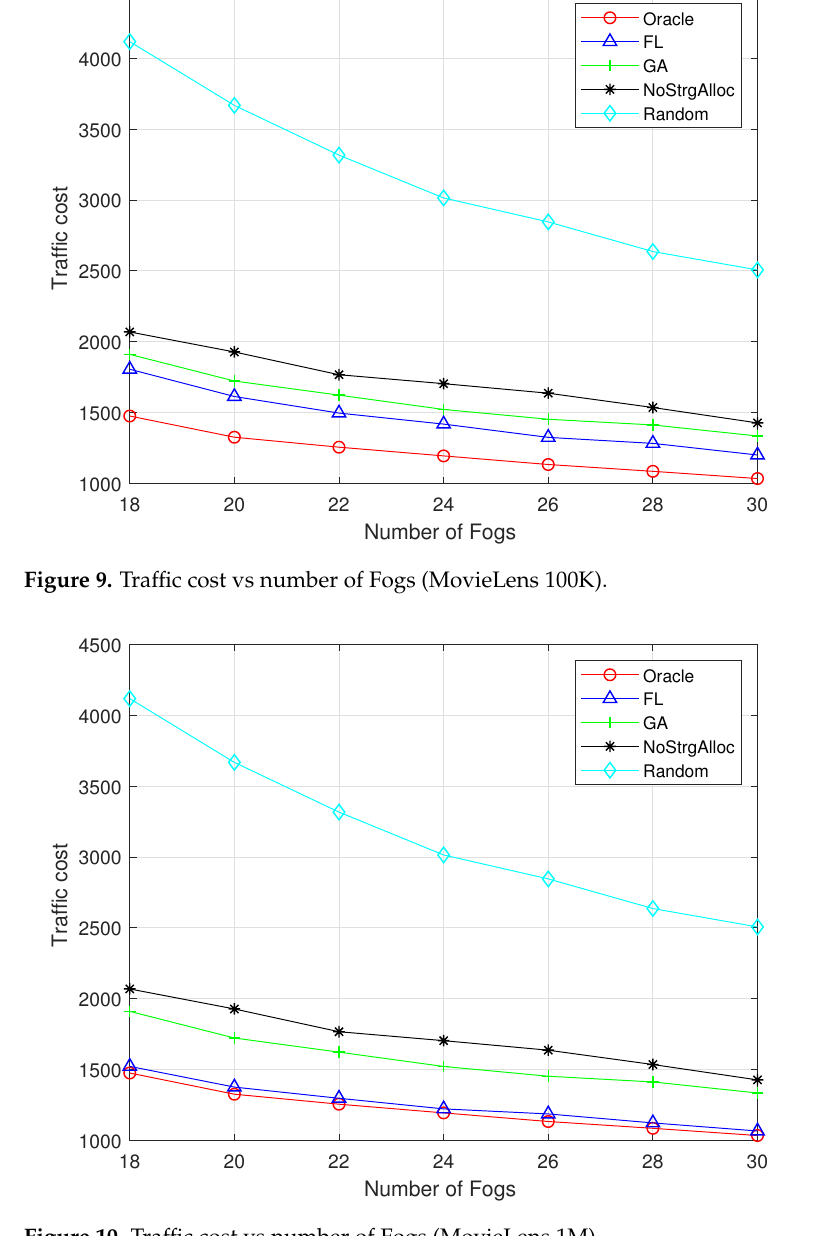
Figure 10. Traffic cost vs number of Fogs (MovieLens